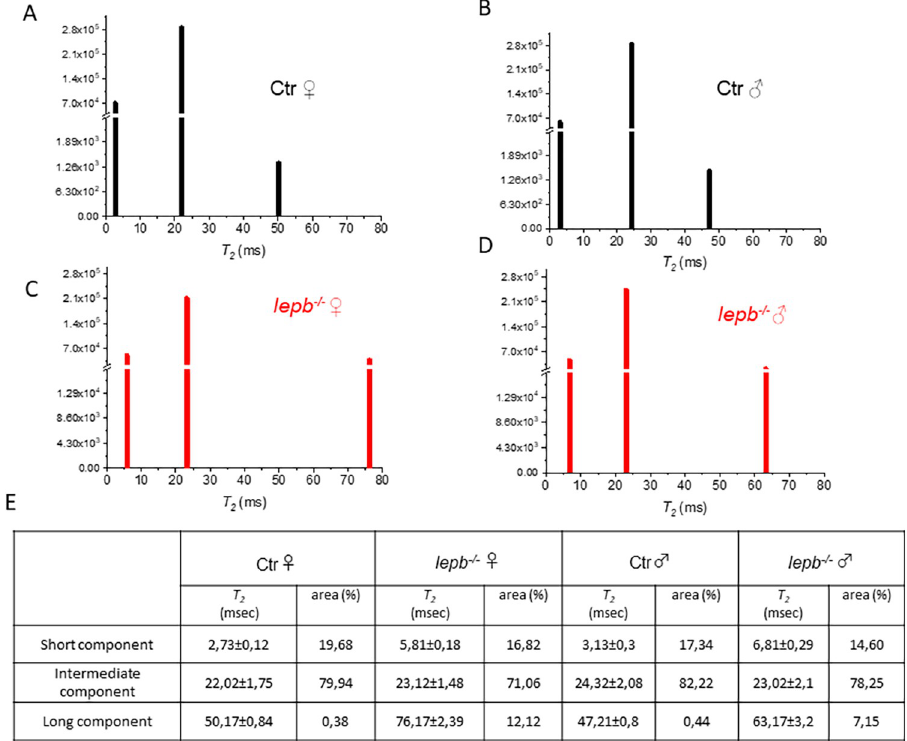
Fig 4. Multicomponent analysis of the experimental T based algorithm (NNLS). NNLS least-squares spectra of (A) Ctr ♀ (B) Ctr ♂ (C) lepb -/- ♀ and (D) lepb -/- ♂ zebrafish in ROIs located in the fat infiltered muscle area. (E) Time and amplitude of various T and long) in msec ± SD and the percentage of areas for each component.